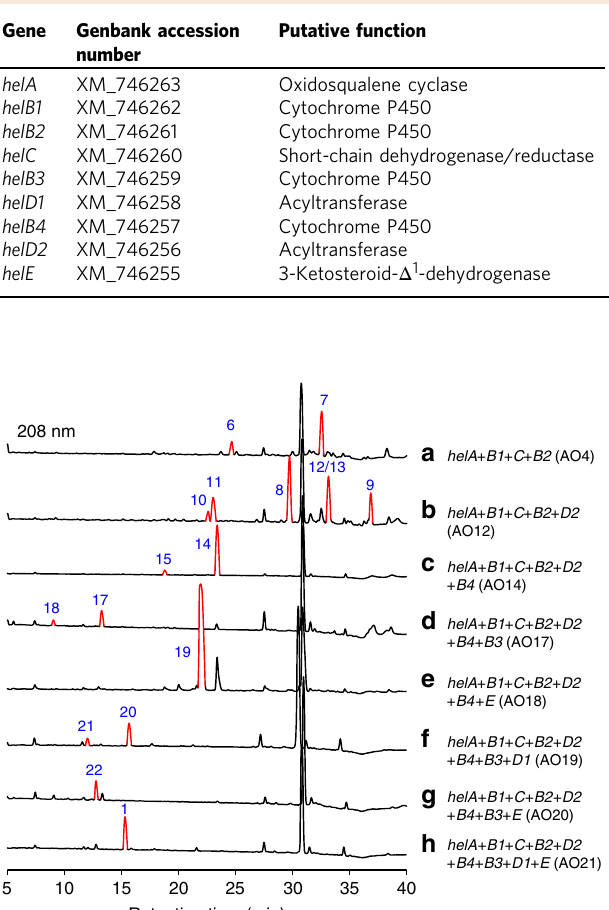
Fig. 1c), and 4 upon co-expression of helA and helB1 (Supple-